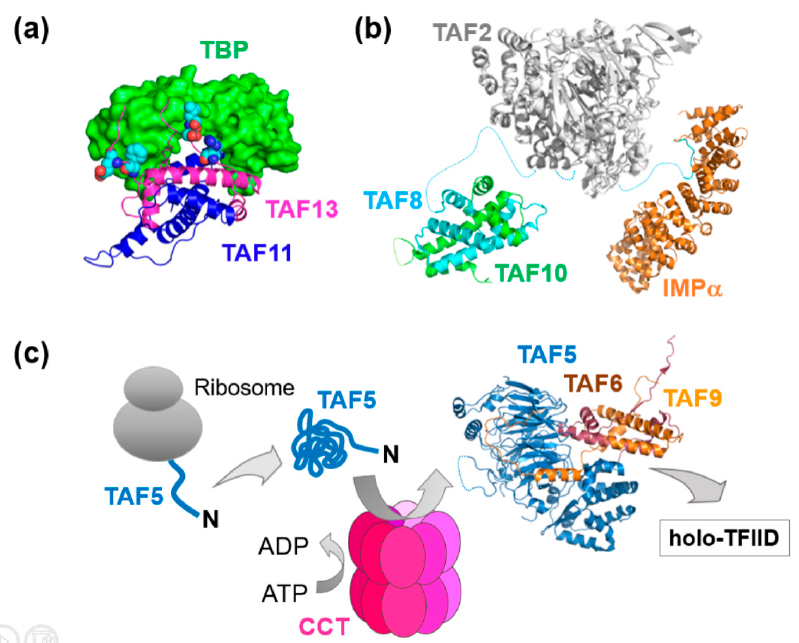
Figure 3. Partial TFIID complexes and mechanisms of TFIID assembly. ( a ) The architecture of TAF11/TAF13/TBP revealed an unexpected binding mode with the TAFs invading the DNA binding groove of TBP [53]. A MultiBac baculovirus customized for genetic code expansion, MultiBac-TAG, was utilized to probe the interaction interfaces by inserting UV-activatable amino acids for cross-linking [55]. ( b ) A nuclear import particle (NIP) formed by TAF8, TAF10, TAF2 and importin is shown, reconstituted from recombinant TAF proteins co-expressed by MultiBac and Importin produced in bacteria [54]. The structures of TAF8/TAF10 and TAF8/Importin were determined by X-ray crystallography, a homology model of TAF2 is shown [50]. ( c ) X-ray crystallography combined with mutational studies, proteomics and cell-based experiments revealed a crucial checkpoint function of the adenylate-dependent chaperonin CCT in the formation of a TAF5/TAF6/TAF9 complex in early stages of human TFIID assembly. CCT captures nascent TAF5 as it emerges from the ribosome, and hands-over folded TAF5 to a preformed TAF6/TAF9 complex in the cytoplasm [51].